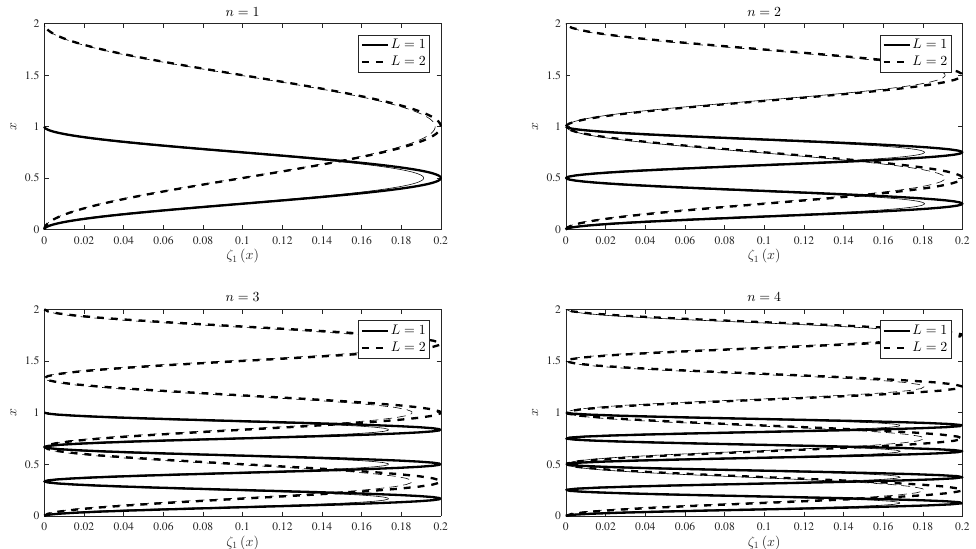
Figure 13. Comparison of the mode shapes of the buckled elastic clamped beam assuming small slope (thick lines), ( ζ (cid:48) ) 2 (cid:28) 1 or assuming a lowest-order non-linear slope (thin lines), ( ζ (cid:48) ) 3 (cid:28) 1, for the four lowest buckling forces, n = 1, . . . ,4. The indeterminate constant is set as b = 0.1, and the length of the beam is L = 1 or L =